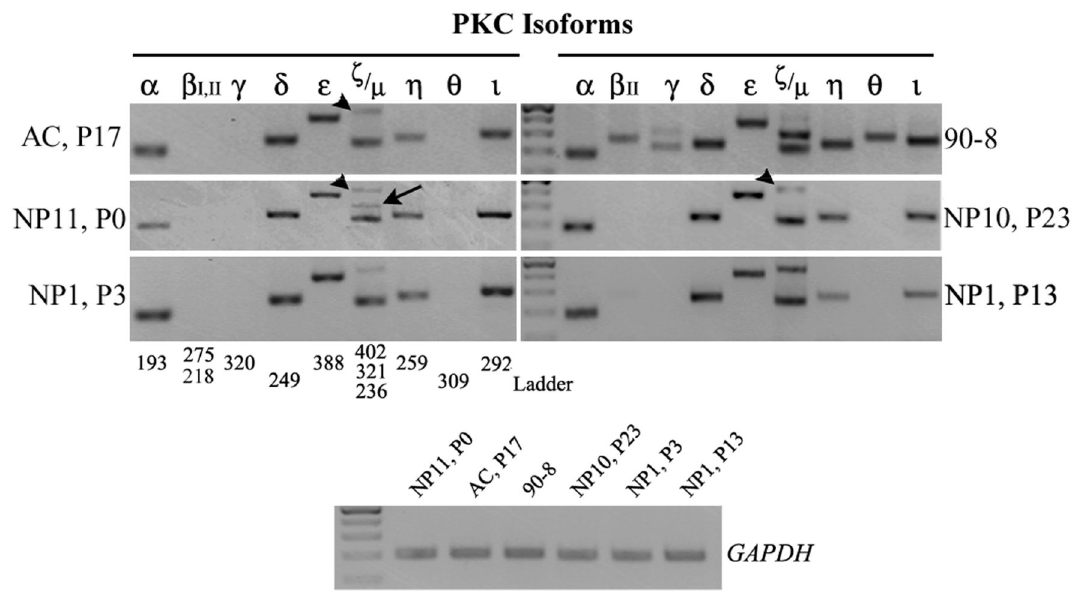
Figure 4. PKC isoform expression in human NP cells of early or late passage. Representative images of RT-PCR results for PKC isoform profiling demonstrate an indistinguishable profile amongst various NP samples and cell passages (NP11, P0; NP10, P23; NP1, at P3 and P13), and AC cells (AC, P17) in culture, with the exception of the ζ isoform, which appears at a slightly different molecular size (402 versus 321 - arrowheads versus arrows). The MPNST 90-8 cell line which expresses all the PKC isoforms but βI, served as a positive control. For each sample, the expression of each gene was examined using identical amounts of cDNA template, as for the housekeeping GAPDH (shown at the bottom row). The ladder used was the GeneRuler 100 bp (NEB), where the intense band corresponds to the 500 bp